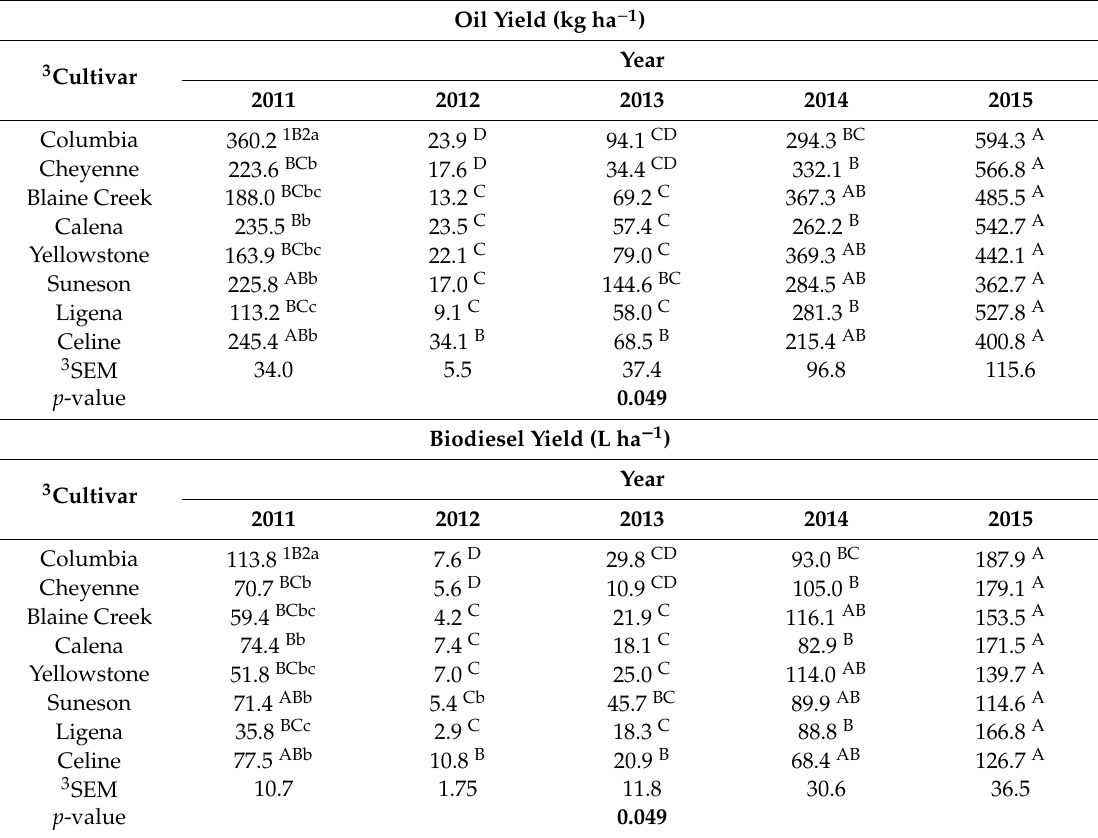
Table 8. Interaction e ff ect of cultivar × year on oil yield (kg ha − 1 ) and biodiesel yield (L ha − 1 ) of the eight C. sativa cultivars grown during the spring growing season of 2011 to 2015 in Reno, Nevada,